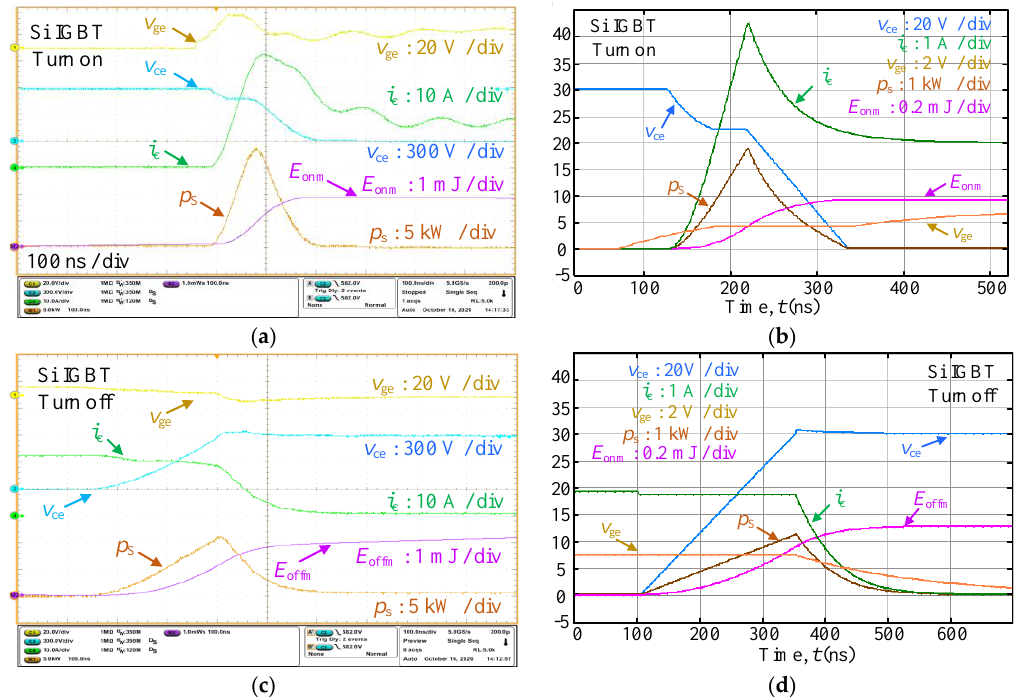
Figure 14. Si IGBT turn on waveforms ( a ) measured; ( b ) simulated; and turn off waveforms ( c ) measured; ( d ) simulated @ 600 V,20 A,25 ℃, 𝑅 G 15 Ω .